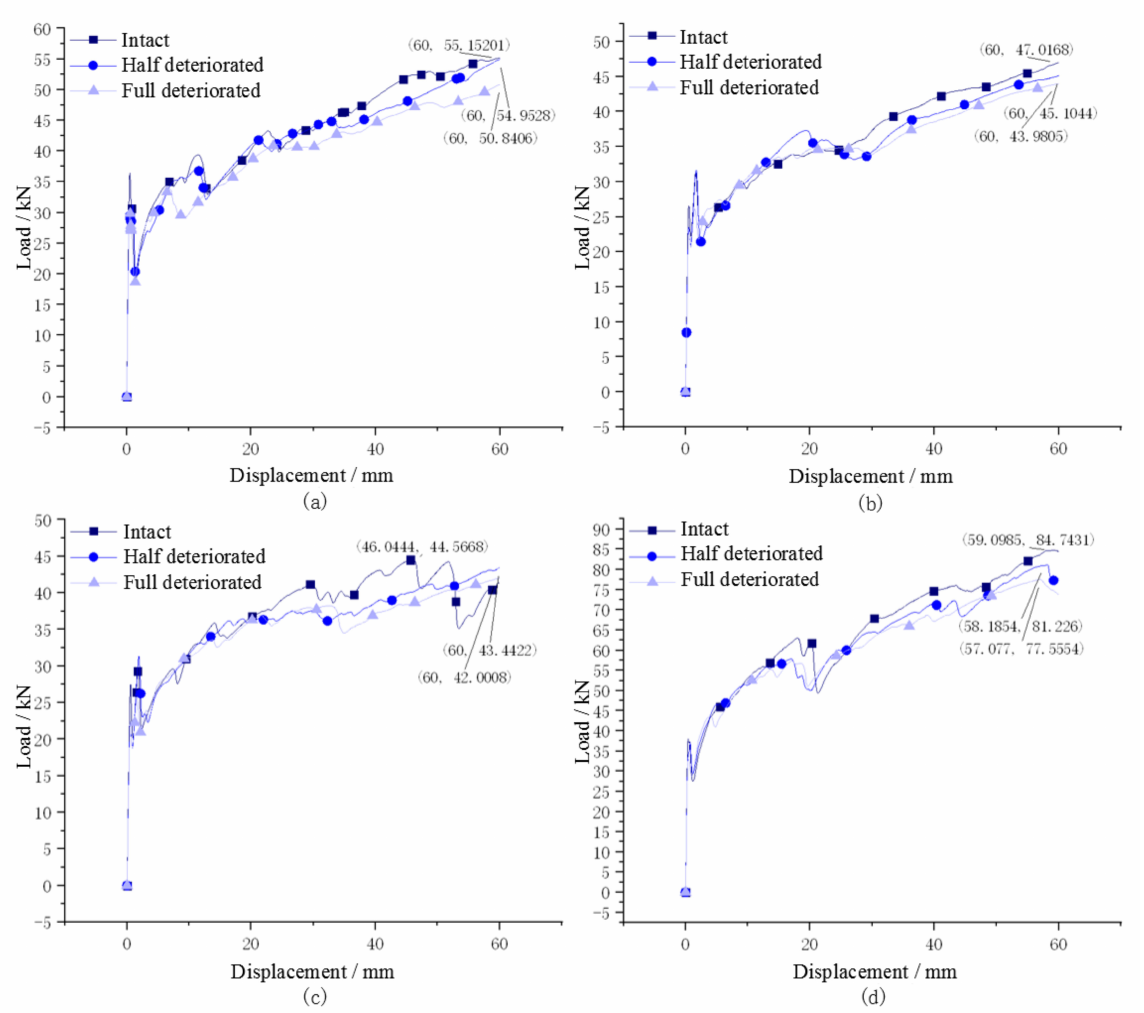
Figure 12. Effect of depth of deterioration on ( a ) circular; ( b ) rectangular; ( c ) arched; and ( d ) trenched cable